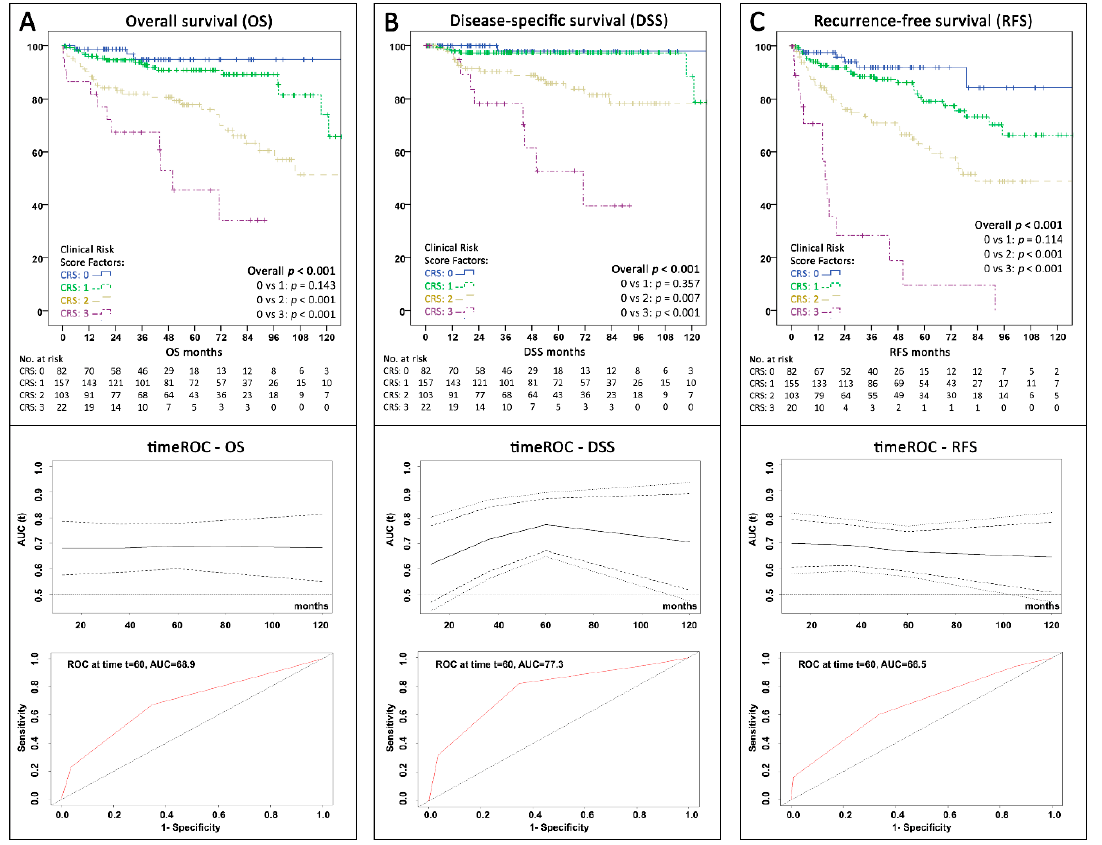
Figure 3. Kaplan–Meier curves with time-dependent receiver operating characteristics (ROC) ( + 95% confidence intervals) over 120 months and area under the curve (AUC) at 60 months showing the survival and predictive value according to the proposed clinical risk score with three factors (presence of metastases, CRP ≥ 0.2 mg / dL, and primary tumor-size ≥ 3 cm) for the whole cohort ( n = 364) ( A ) Overall survival ( B ) Disease-specific survival (death due to panNEN progression) ( C ) Recurrence-free survival. AUC = Area under the curve; CRS = Clinical risk score; ROC = receiver operating characteristics; t60 = timepoint 60 months; timeROC = time-dependent receiver operating characteristics.